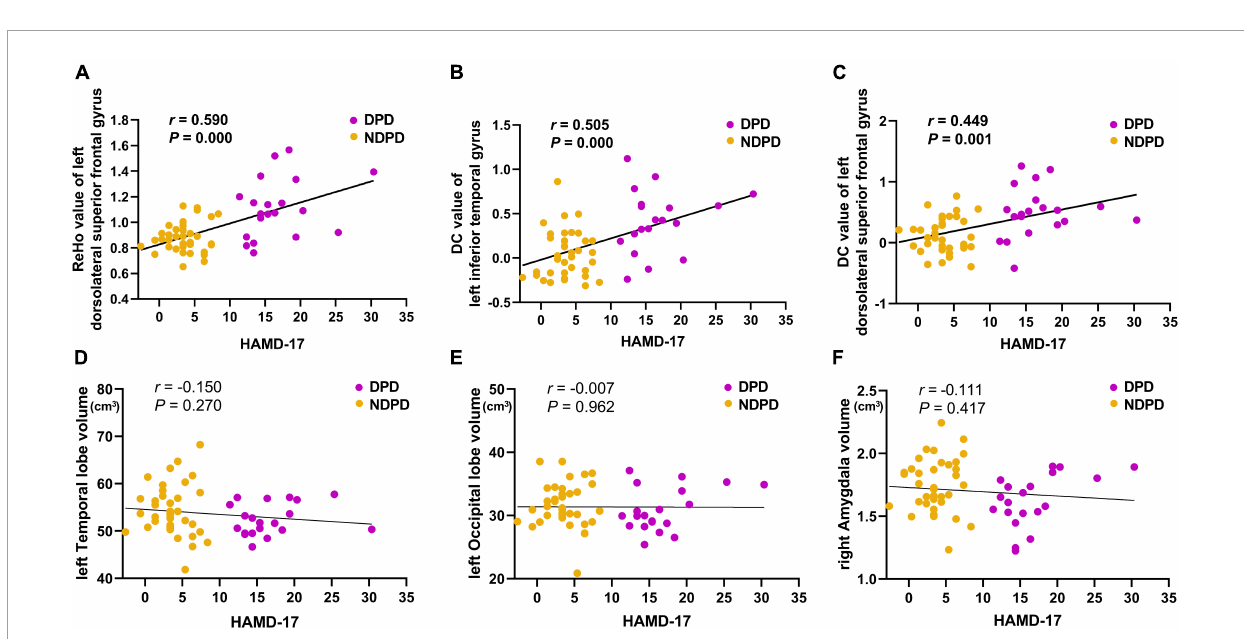
FIGURE4 The correlations of (A) the ReHo value of left dorsolateral superior frontal gyrus, (B) the DC value of left inferior temporal gyrus, (C) the DC value of left dorsolateral superior frontal gyrus, (D) the left temporal lobe volume, (E) the left occipital volume, and (F) the right amygdala volume with the HAMD-17 scores. MMSE was used as the covariate of results (Bonferroni corrected, p <